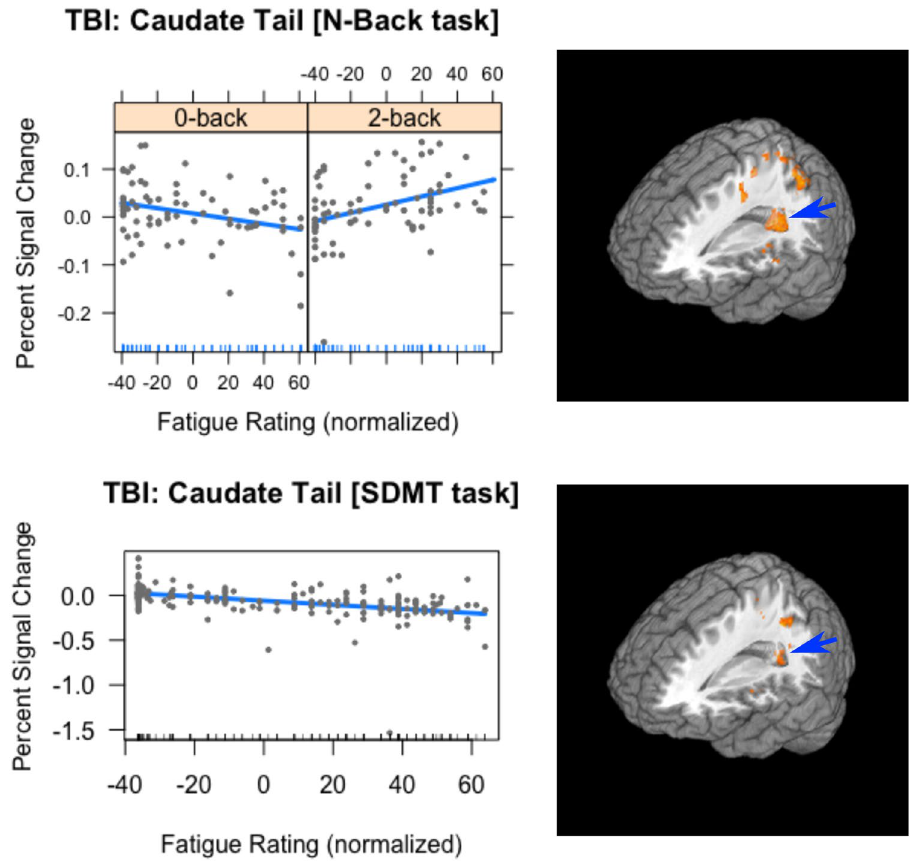
Figure 3. The relationship between Fatigue and activation in the caudate tail in the TBI group across Experiments. The plots on the left are included only to show the slopes of the regression lines. For the 0-back task (top left), there was a negative relationship between Fatigue and activation, while the relationship was positive for the 2-back task (top right). For the SDMT, the relationship between Fatigue and activation was not modulated by Task: for both tasks the relationship was negative (lower plot). For all plots the vertical axis is the percent signal change in the caudate tail and the horizontal axis is the normalized fatigue score. On the right are 3-dimensional renderings of the activation in the caudate tail (indicated by blue arrow) for the N-Back task (top) and the SDMT